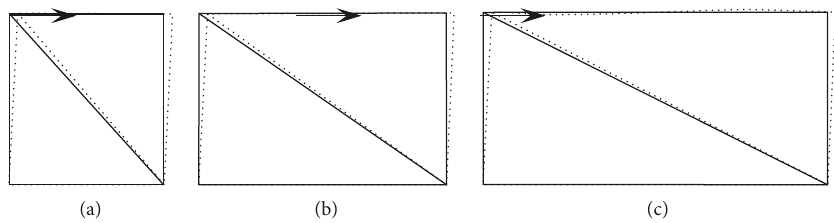
Figure 12: Deformed shape of the equivalent strut models with IPE220. (a) M-1.8m-IPE220. (b) M-2.9m-IPE220. (c)